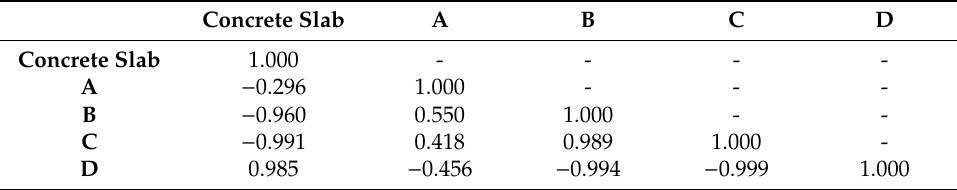
Table 3. A correlation matrix of the groups of loading steps from Figure 8.